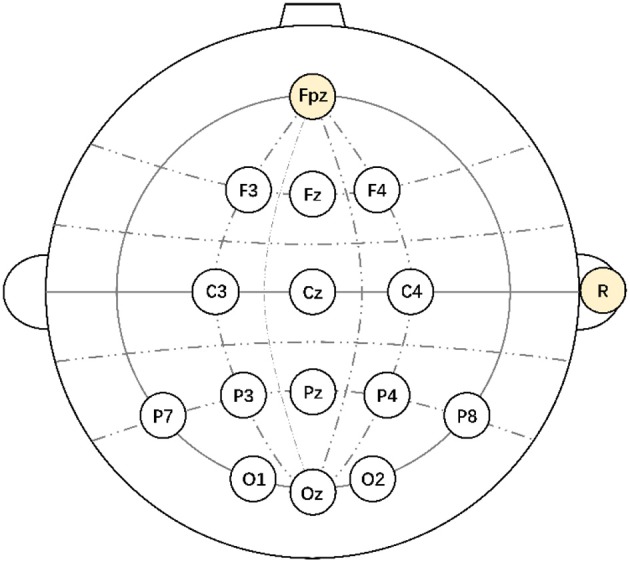
The electrodes selected from the 10–20 system.